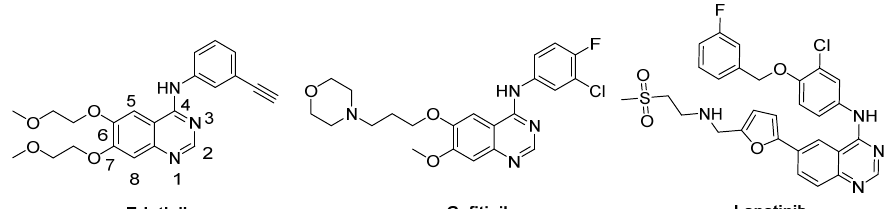
Figure 1. Representative compounds of RTK